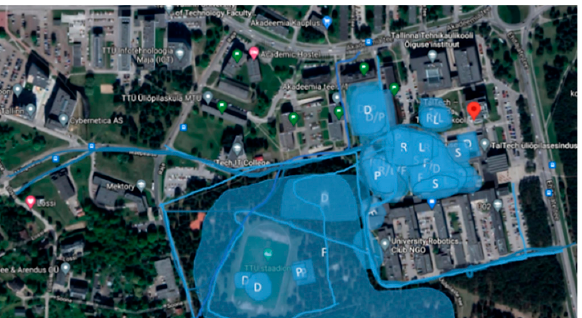
Figure 5. Taltech campus map with colored preferred areas for different outdoor activities. R = reading a book, L = working with the laptop, D = dancing, S = sunbathing, P = picnic, and F = favorite spot. Blue lines represent preferred cycling routes [48].